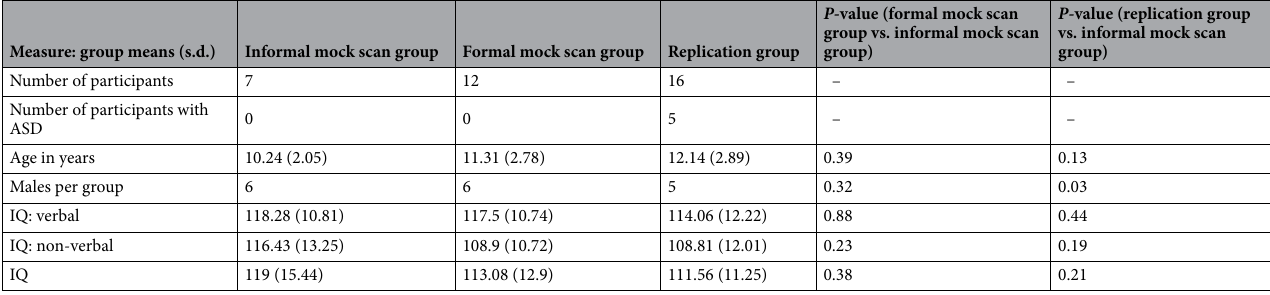
Table 1. Demographic